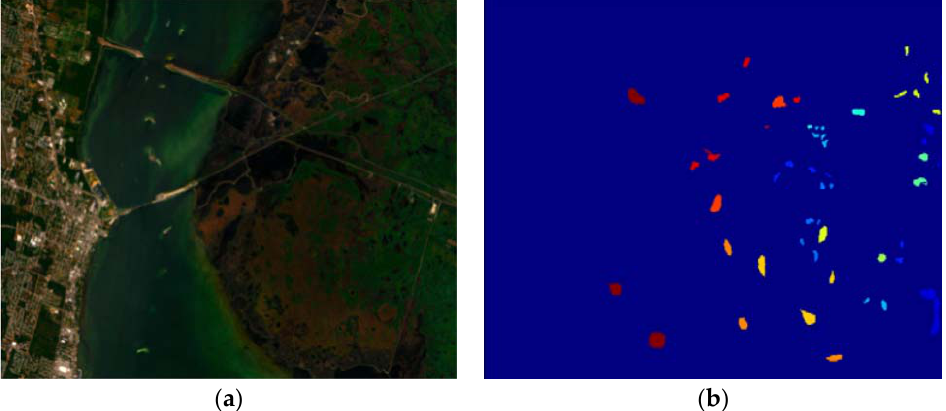
Figure 7. Kennedy Space Center (KSC) data set. ( a ) False ‐ color image of the KSC data. ( b ) Ground ‐ truth map of the KSC.